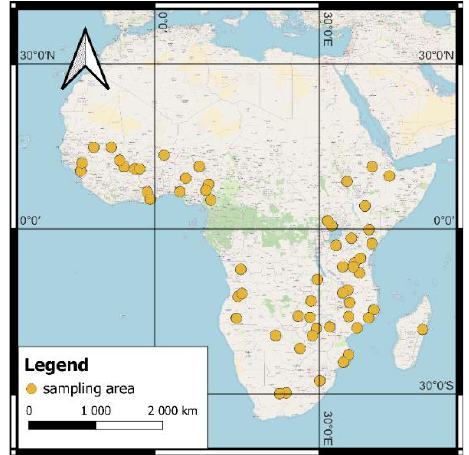
Figure 1. Locations of sampling areas in the AfSIS Phase I project. In each sampling area, a dozen sampling points were selected and the samples were taken from topsoil and subsoil layers.